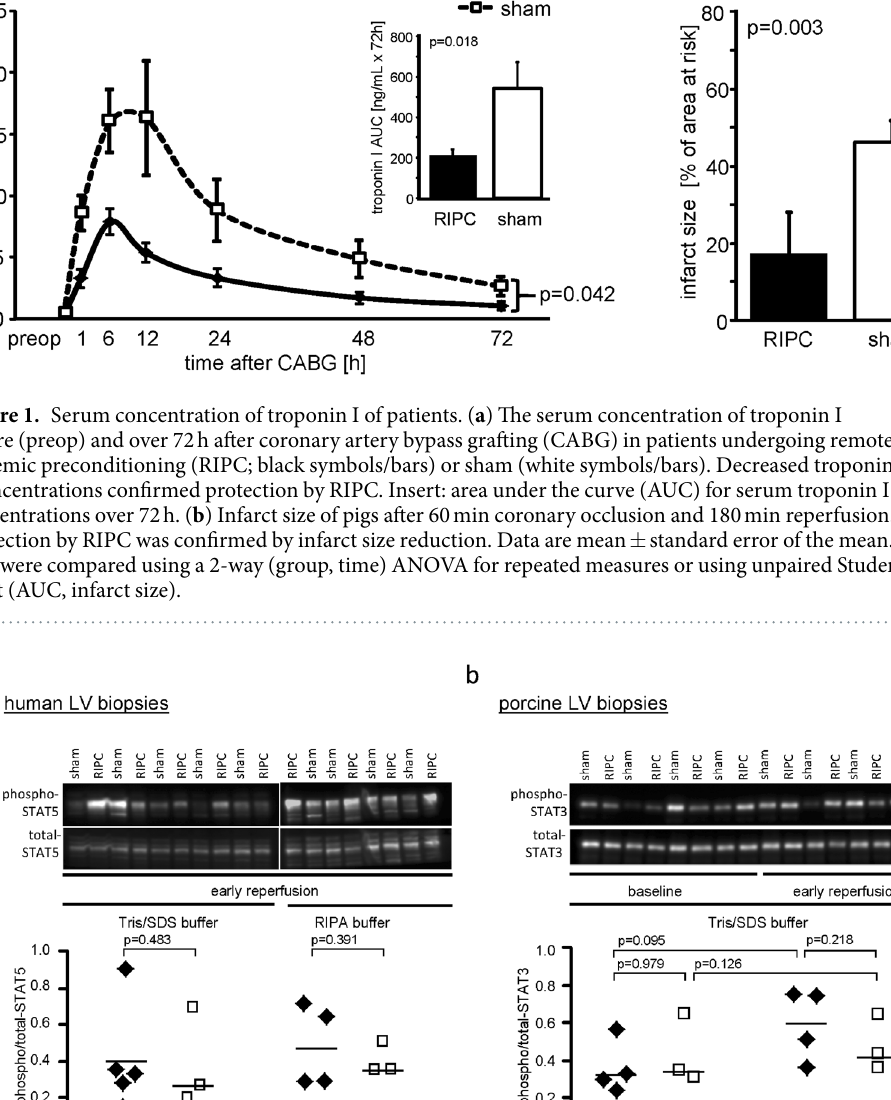
suggesting that phosphorylation of these proteins was induced by coronary occlusion/reperfusion per se. Fourty of these identified proteins were previously not described in cardiac cells, however, 45 proteins were previously described in cardiac cells, among them 4 in the context of ischemia/reperfusion, and 7 in relation to cardiopro- tection or ischemic conditioning maneuvers (Table 3).